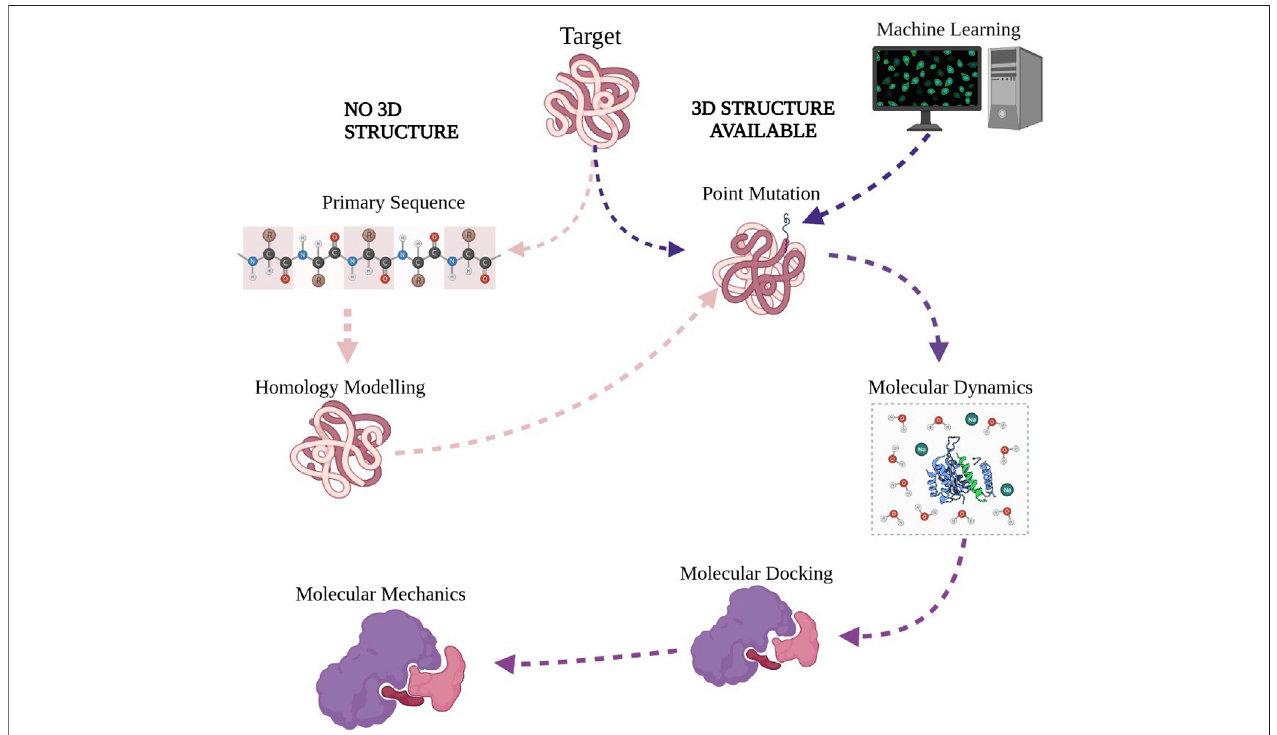
FIGURE 4 | Proposed protocol for studying the effect of mutations on protein – ligand